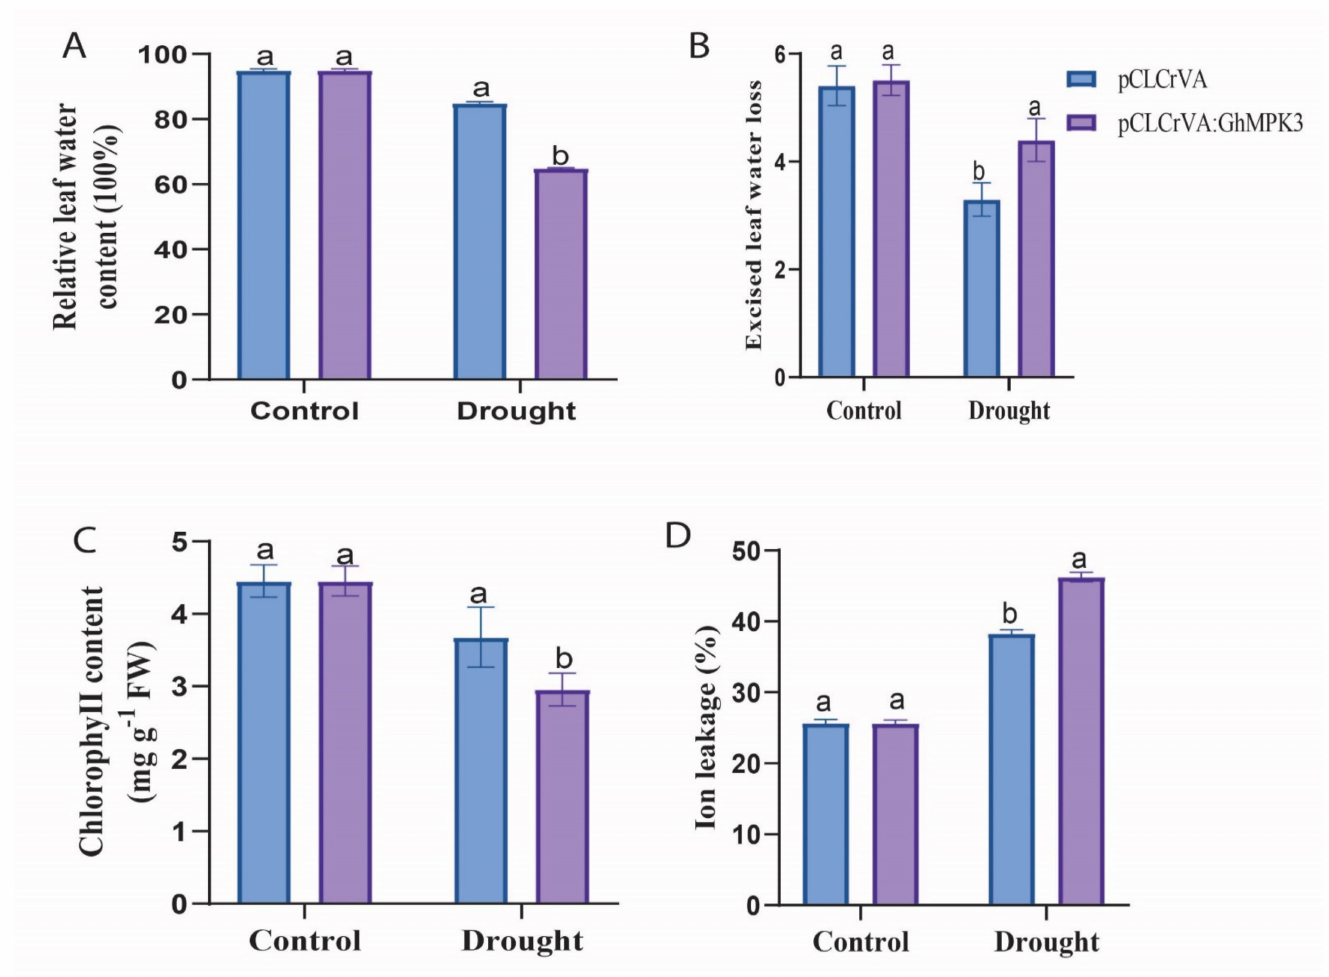
Figure 9. Evaluation of physiological parameters in GhMPK3- VIGS plants: ( A ) RLWC, ( B ) ELWL, ( C ) Chlorophyll, and ( D ) Ion leakage concentration in the leaves of empty vector and GhMPK3- VIGS, the assessment was performed after 10 days of drought exposure and control. Each experiment was conducted three times. The error bar represents the three biological replicate’s standard deviation. The significant differences between VA and GhMPK3 -VIGS plants (ANOVA; p < 0.05) are indicated by different letters